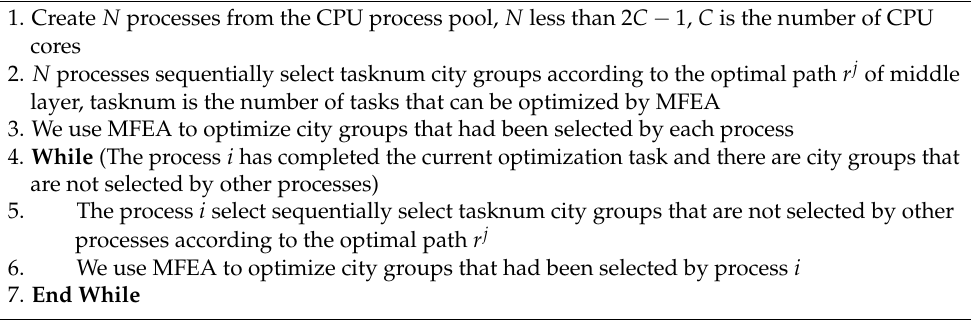
Algorithm 2 Parallel Path Optimization in the bottom